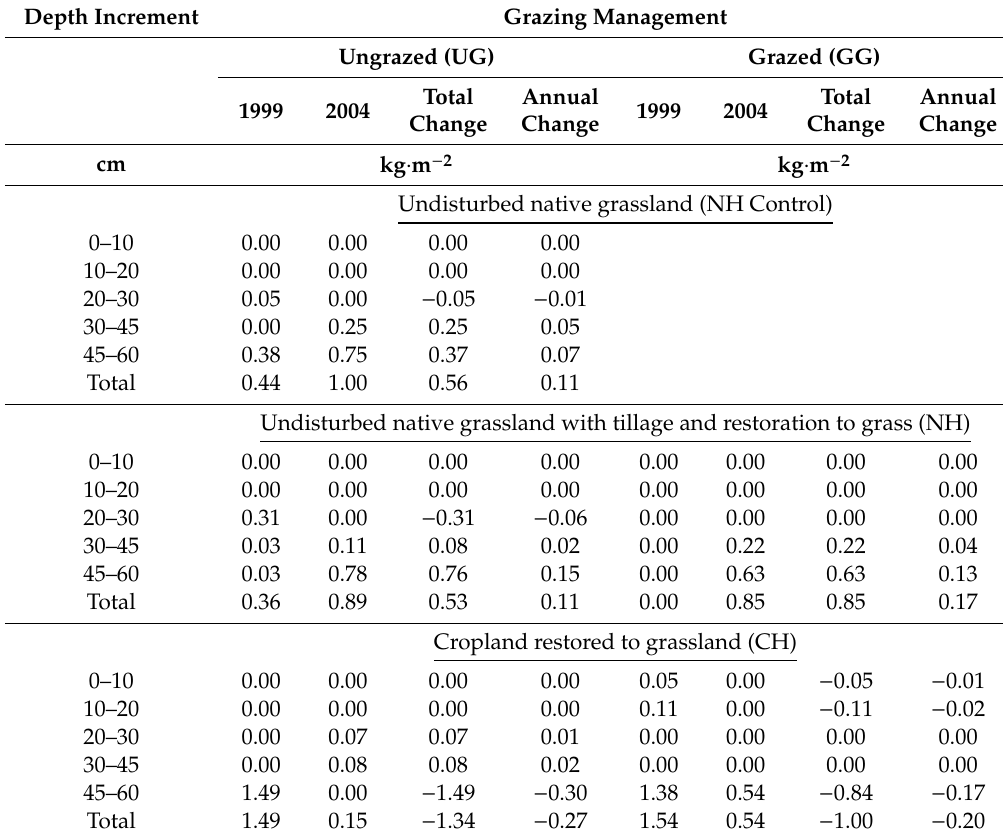
Table 3. E ff ects of management on profile changes in soil inorganic carbon levels over a five year period for undisturbed native grassland, undisturbed native grassland that was tilled and restored to grassland and long-term cropland converted to